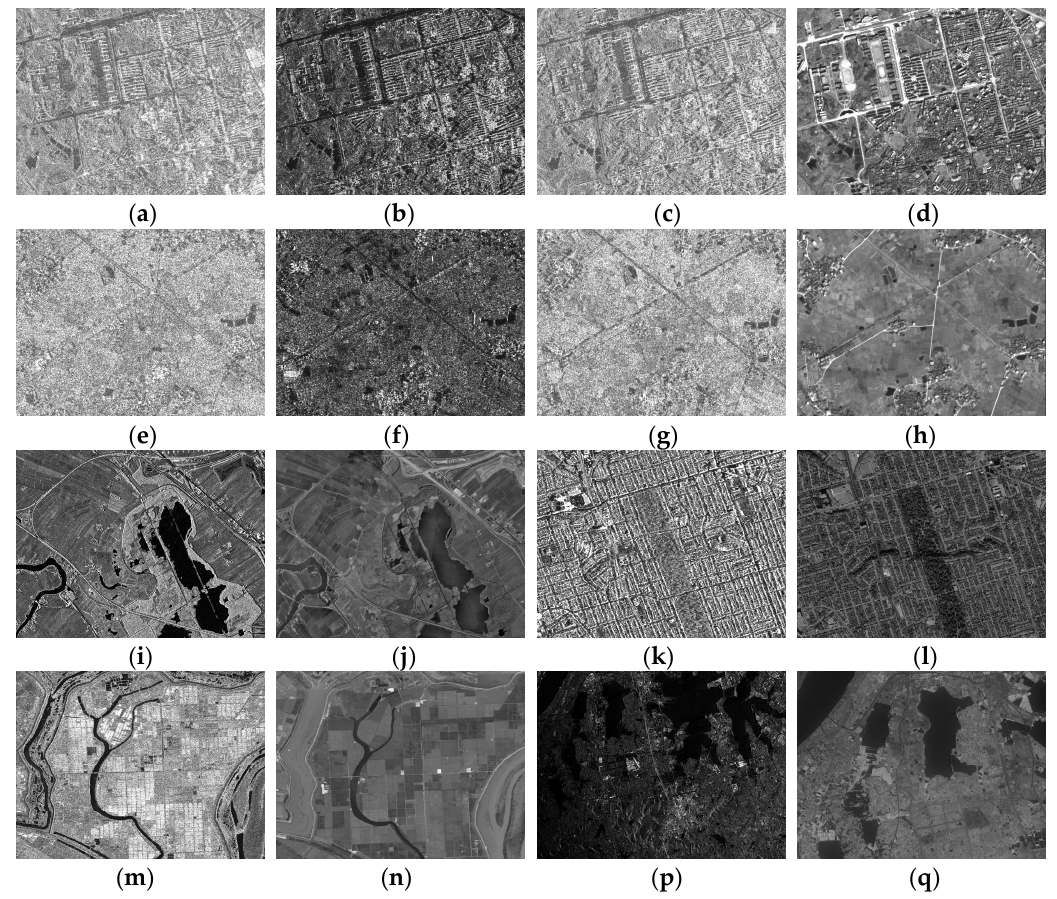
Figure 7. Experimental images. The images in ( a – d ) are the COSMO-Skymed image, RADARSAT-2 image, TerraSAR-X image, and ZY-3 visible image of a building area in China, respectively. The images in ( e – h ) are the COSMO-Skymed image, RADARSAT-2 image, TerraSAR-X image, and ZY-3 visible image of a rural area in China, respectively. ( i , j ) are a pair of TerraSAR-X and Google earth images in Netherlands. ( k , l ) are a pair of TerraSAR-X and Google earth images in Canada. ( m , n ) are a pair of TerraSAR-X and Google earth images in China. ( p , q ) are a pair of HJ-1C and ZY-3 images in China.